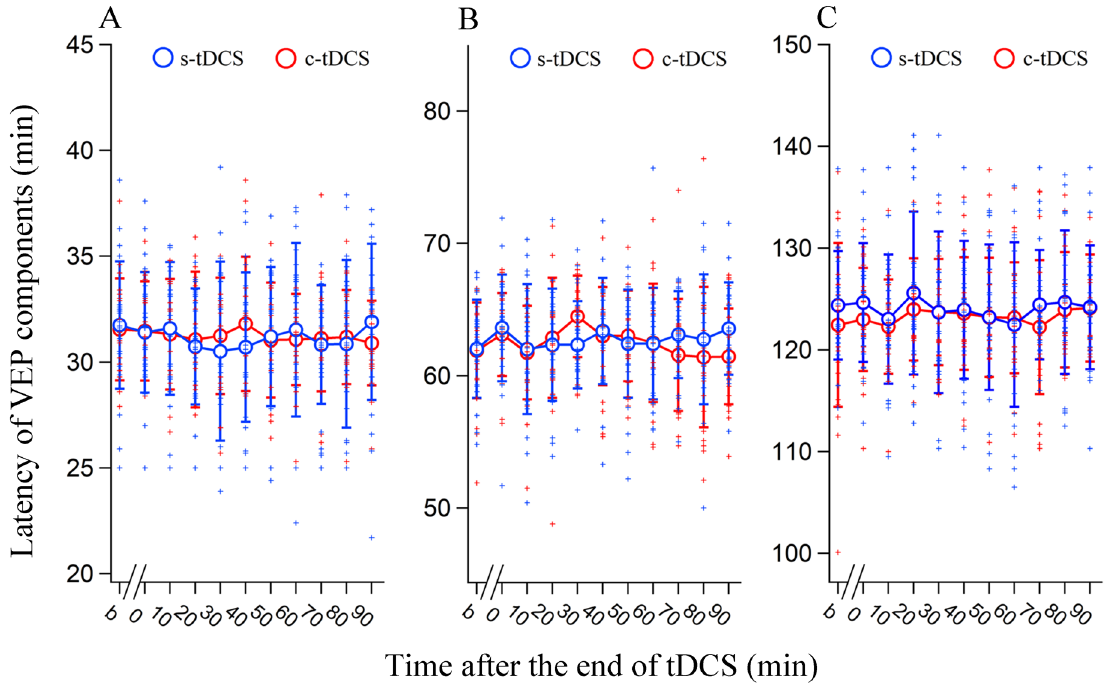
Figure 2. The latency at the peak of wave N1 ( A ), P1 ( B ), and N2 ( C ) of VEPs recorded in the V1 cortex across all cats before and at different time (0, 10, 20, 30, 40, 50, 60, 70, 80, and 90 min) after the end of tDCS in the area 7 (A7). The b indicates the measurement of VEP latency before tDCS. The blue and red open circles with error bars (SDs) indicate the mean latency measured at each time point before and after sham (s-) tDCS and cathodal (c-) tDCS in A7, respectively. The blue and red crosses represent individual data points of 24 measurements in four cats (six repeated measurements/cat) before and after s- and c-tDCS in A7, respectively. Image created using Igor (version 6.3.1.2, www. wavem etrics. different time point after tDCS in A7 exhibited a significant variation [N1P1: F(10,506) = 102.928, p < 0.0001; P1N2: F(10,506) = 153.869, p < 0.0001], but the effect was dependent on tDCS polarity [N1P1: F(10,506) = 101.704, p < 0.0001; P1N2: F(10,506) = 172.037, p < 0.0001] (Fig. 3A,B). Therefore, we further compared VEP amplitude value at different measurement time point under s- and c-tDCS in A7, respectively. One-way ANOVA displayed that the mean N1P1 and P1N2 measured in the V1 cortex at different time point before and after s-tDCS in A7 had no significant difference [N1P1: F(10,253) = 0.444, p = 0.924; P1N2: F(10,253) = 0.431, p = 0.931]. Nev- ertheless, the mean N1P1 and P1N2 measured at different time point before and after c-tDCS in A7 exhibited significant difference [N1P1: F(10,253) = 248.202, p < 0.0001; P1N2: F(10,253) = 390.693, p < 0.0001]. Further post-hoc test indicated that the mean N1P1 measured at 0, 10, 20, 30, 40, 50 and 60 min after the end of c-tDCS was significantly decreased compared with that before c-tDCS (all p < 0.0001), whereas the mean N1P1 meas- ured at 70, 80 and 90 min after c-tDCS did not differ significantly from that before c-tDCS (p = 0.314, 0.976, and 0.947). Similarly, the mean P1N2 value measured at 0, 10, 20, 30, 40, 50, and 60 min after the end of c-tDCS was also reduced compared with that before c-tDCS (all p < 0.0001), whereas the mean P1N2 measured at 70, 80, and 90 min after the end of c-tDCS showed no significant difference from that before c-tDCS (p = 0.191, 0.761, and 0.510) (Fig. 3A,B). These comparisons indicated that c-tDCS, but not s-tDCS, in A7 suppressed neuronal excitability in the V1 cortex as indicated by a significantly lowered VEPs amplitude (lowered up to 47.1% in N1P1 amplitude and 42.8% in P1N2 amplitude), and the effects lasted for 60–70 min. To confirm whether the lowered VEPs amplitude in the V1 cortex after c-tDCS in A7 was caused by alterations in top-down influence of A7 or by direct impact of current diffusion across cortical regions, we further examined c-tDCS related VEPs change in the V1 cortex after neuronal activity in A7 was abolished by electrolytic lesions. Morphological studies showed that almost all area of A7 in the left hemisphere was damaged by electrolytic lesions compared with that of normal A7 in the right hemisphere (Fig. 4A,B). VEPs recording also displayed that the main components of VEPs in A7 disappeared after electrolytic lesions compared with that before lesion (Fig. 4C,D). Statistical comparisons showed that the mean latency of wave N1, P1 and N2 of VEPs recorded in the V1 cortex before and at different time point after the end of c-tDCS in A7 exhibited no significant difference [N1: F(10,253) = 0.757, p = 0.67; P1: F(10,253) = 0.784, p = 0.644; N2: F(10,253) = 0.308, p = 0.979] (Fig. 4E,F). Fur- thermore, the mean value of peak-to-peak amplitude of VEPs measured in the V1 cortex at different time point after c-tDCS in A7 had no significant difference from that before c-tDCS [N1P1: F(10,253) = 0.708, p = 0.717; P1N2: F(10,253) = 0.316, p = 0.97] (Fig. 4E,G) although the VEPs amplitude of N1P1 and P1N2 in the V1 cortex after lesion of A7 was evidently lower than before lesion of A7 (Figs. 3A,B, 4G).